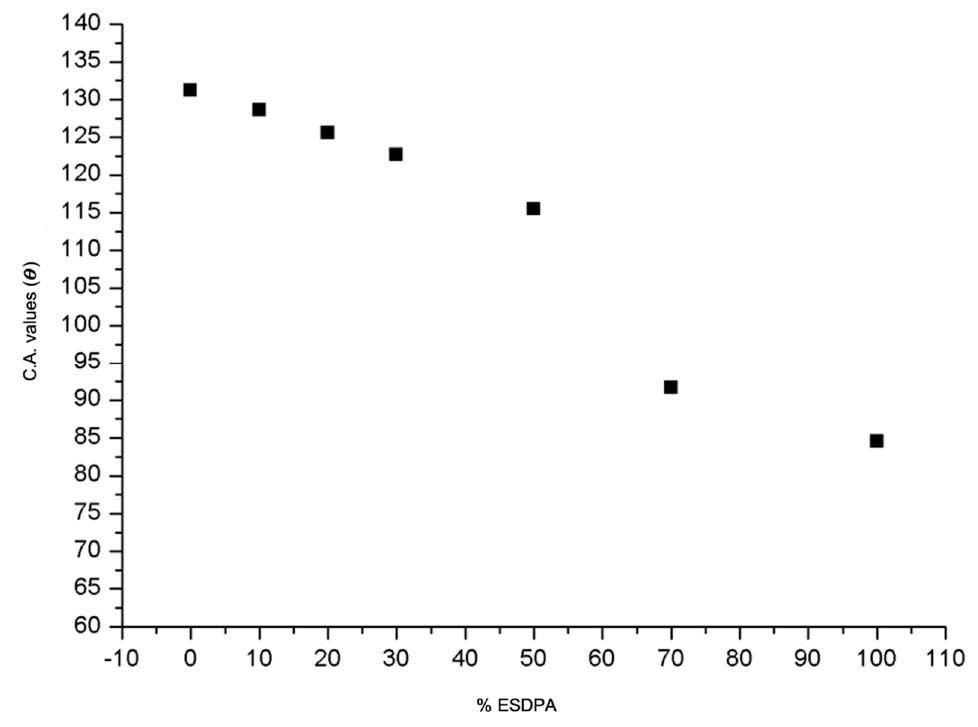
Figure 10. Contact Angle values ( θ ) vs. %ESDPA units.